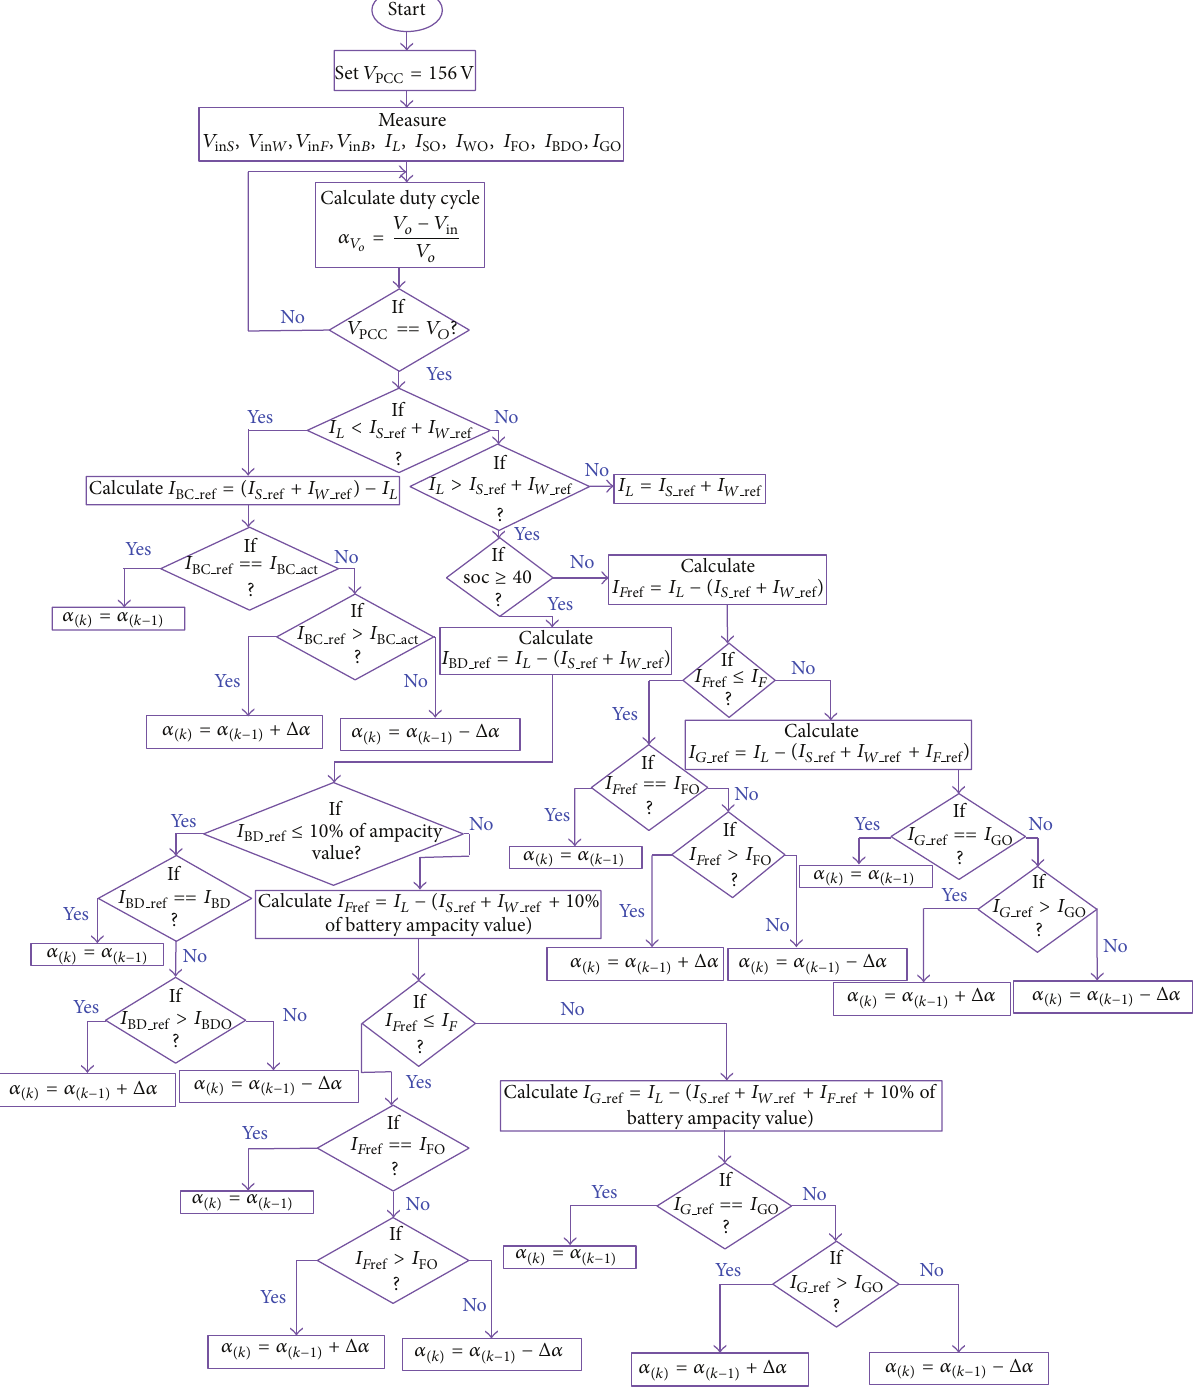
Figure 19: Flowchart of control